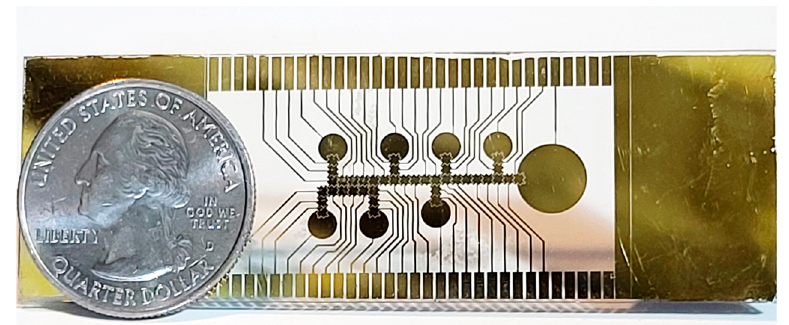
Figure 4. Completed EWOD chip